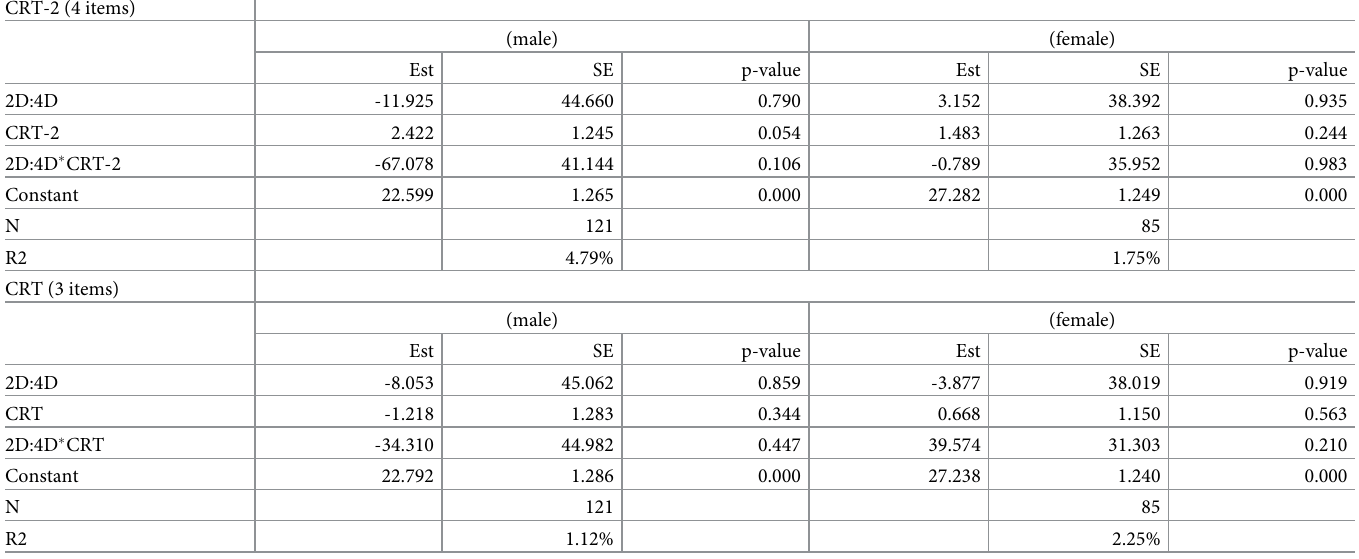
Table 3. SVO angle as a function of 2D:4D and cognitive